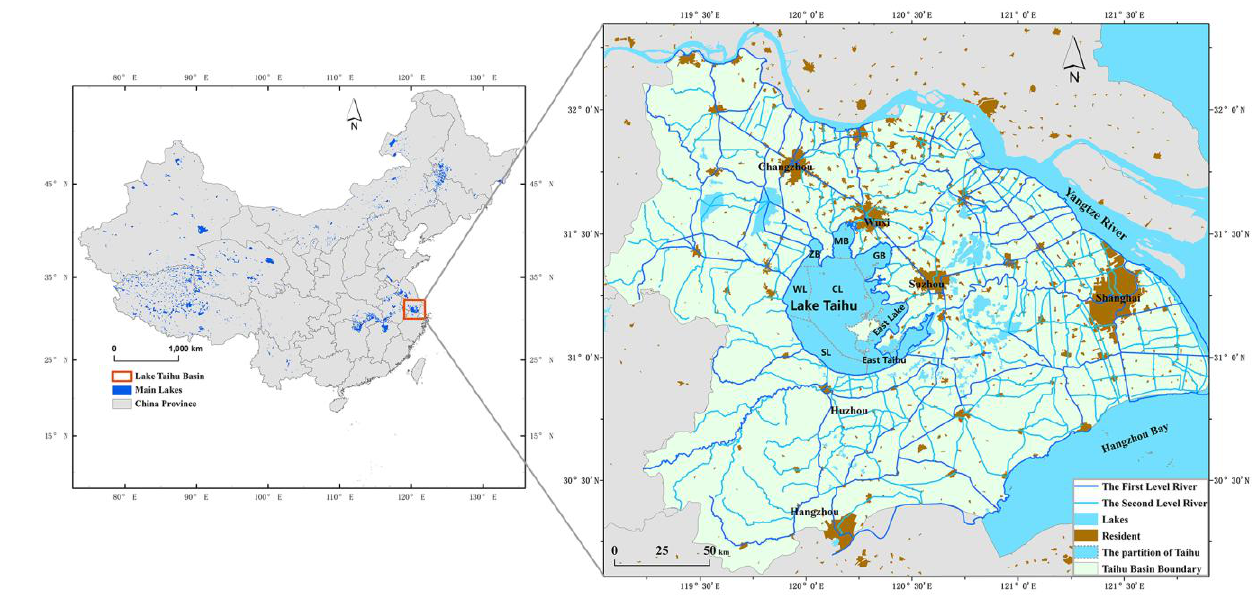
Figure 1. Lake Taihu, China in the Yangtze River Delta. The lake is divided into lake sections, including Zhushan Bay (ZB), Meiliang Bay (MB), Gong Bay (GB), West